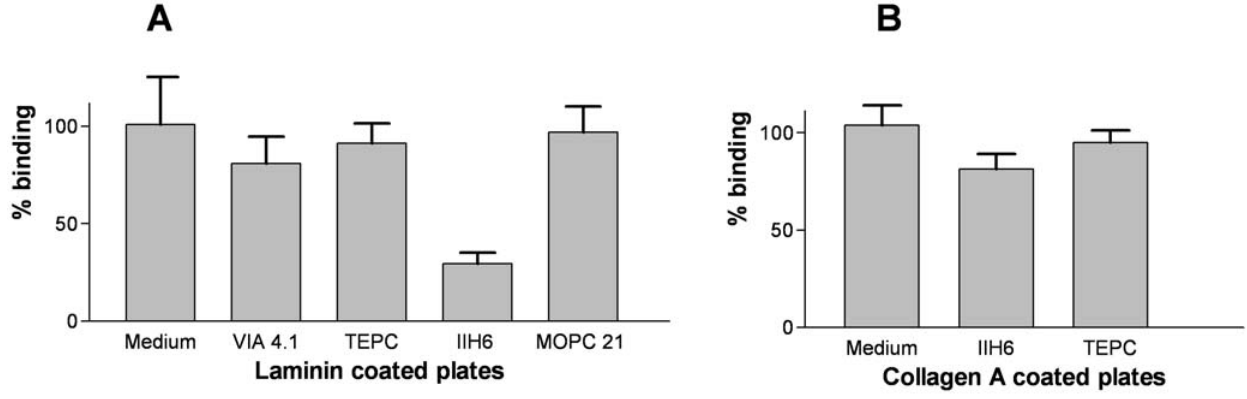
Figure 1. Inhibition of podocyte binding to laminin by anti a -dystroglycan monoclonal antibodies IIH6 and VIA 4.1. Podocytes were seeded on laminin (A) or collagen A coatings (B) after pre-incubation with either monoclonal antibody IIH6 using TEPC as an isotype control, or with VIA 4.1 using MOPC 21 as an isotype control. Monoclonal antibody IIH6 specifically inhibits podocyte binding to laminin, but not to collagen A.